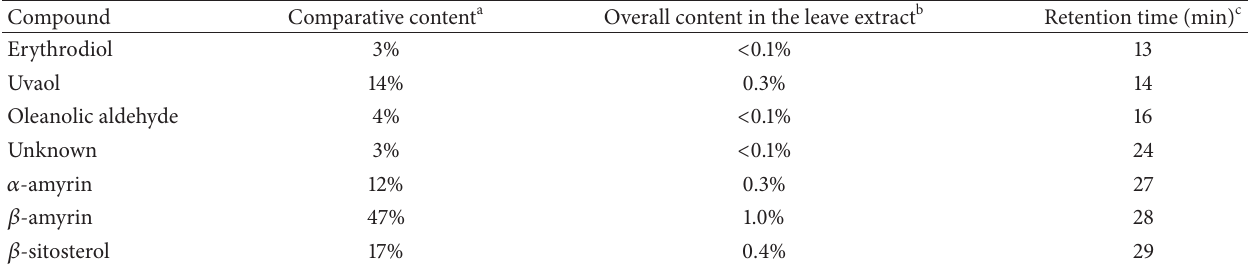
Table 3: Composition of the fraction of conjugated phytosterols in the sea buckthorn leaves determined by HPLC-NMR. Compound Comparative content a Overall content in the leave extract b Retention time (min) c 𝛼 -amyrin + FA 11% 0.6% 15 18% 1.0% 12% 0.6%